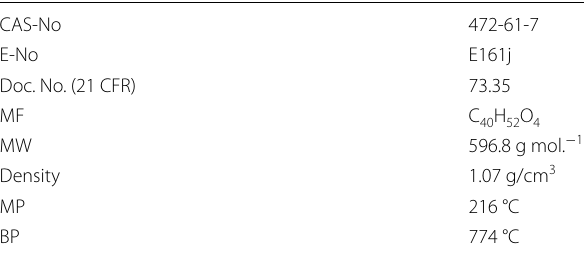
Fig. 1 Orientation of astaxanthin, β-carotene, vitamin C and vitamin E in plasma